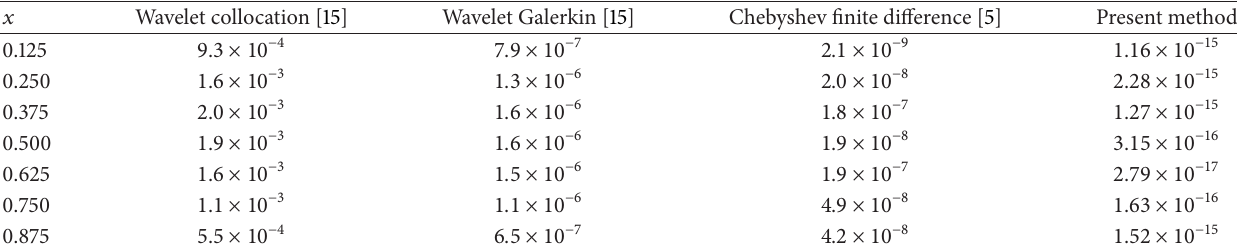
Table 1: A comparison of absolute errors between Wc, WG, Cfd, and present method.